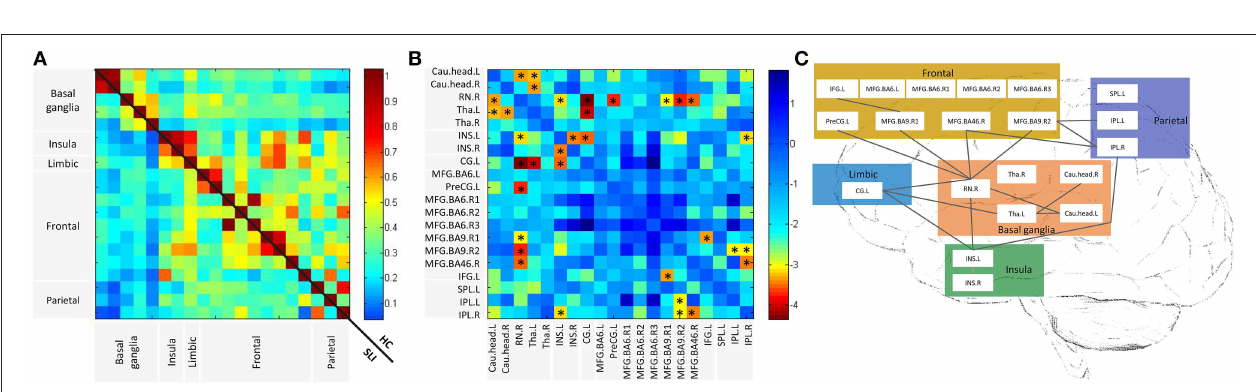
FIGURE 1 | Comparison of structural BG-cortical connectivity between SLI patients and controls. White matter tracts connecting the BG to the lateral frontal area and orbital frontal cortex in the left hemisphere and to the lateral frontal area and insula in the right hemisphere are represented in a 3D brain model. The bar charts show the average FA ± SEM within each tract compared between SLI patients (orange) and controls (blue). BG, basal ganglia; SLI, silent lacunar infarct; FA, fractional anisotropy; SEM, standard error of the mean.